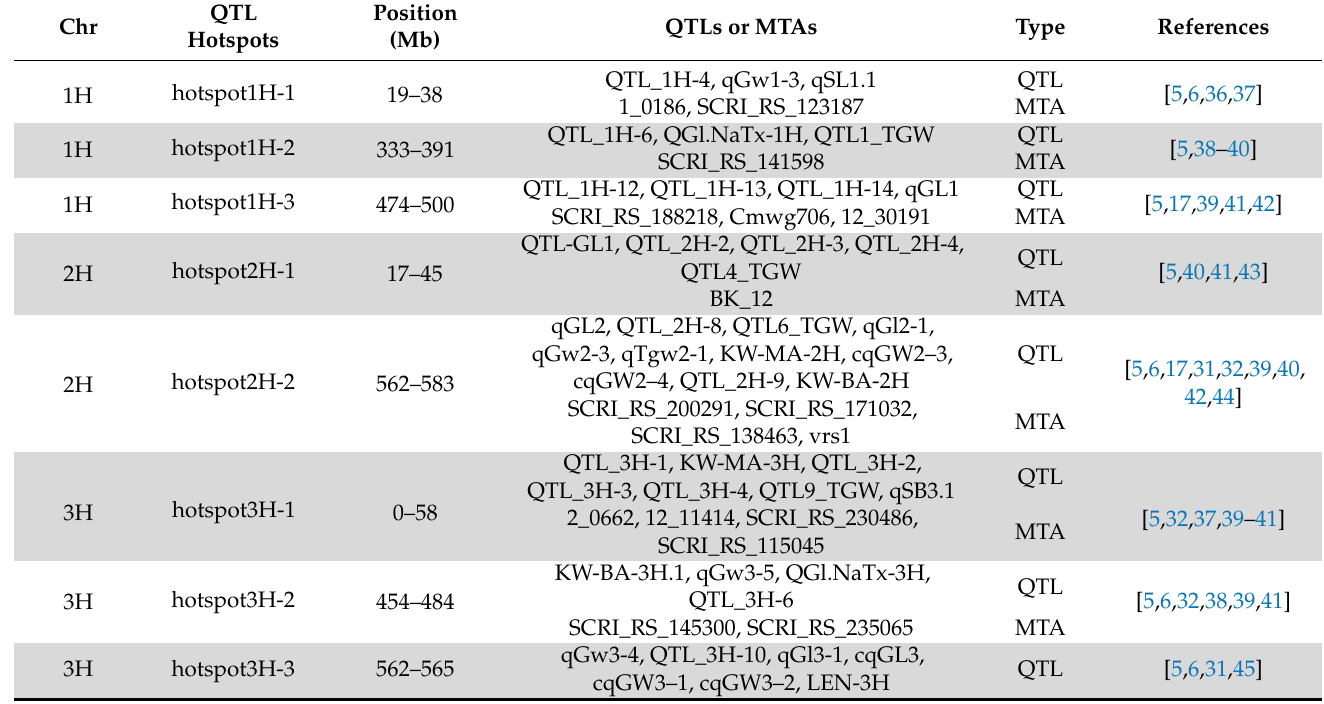
Table 1. Information of the grain size of the QTL hotspots across all seven